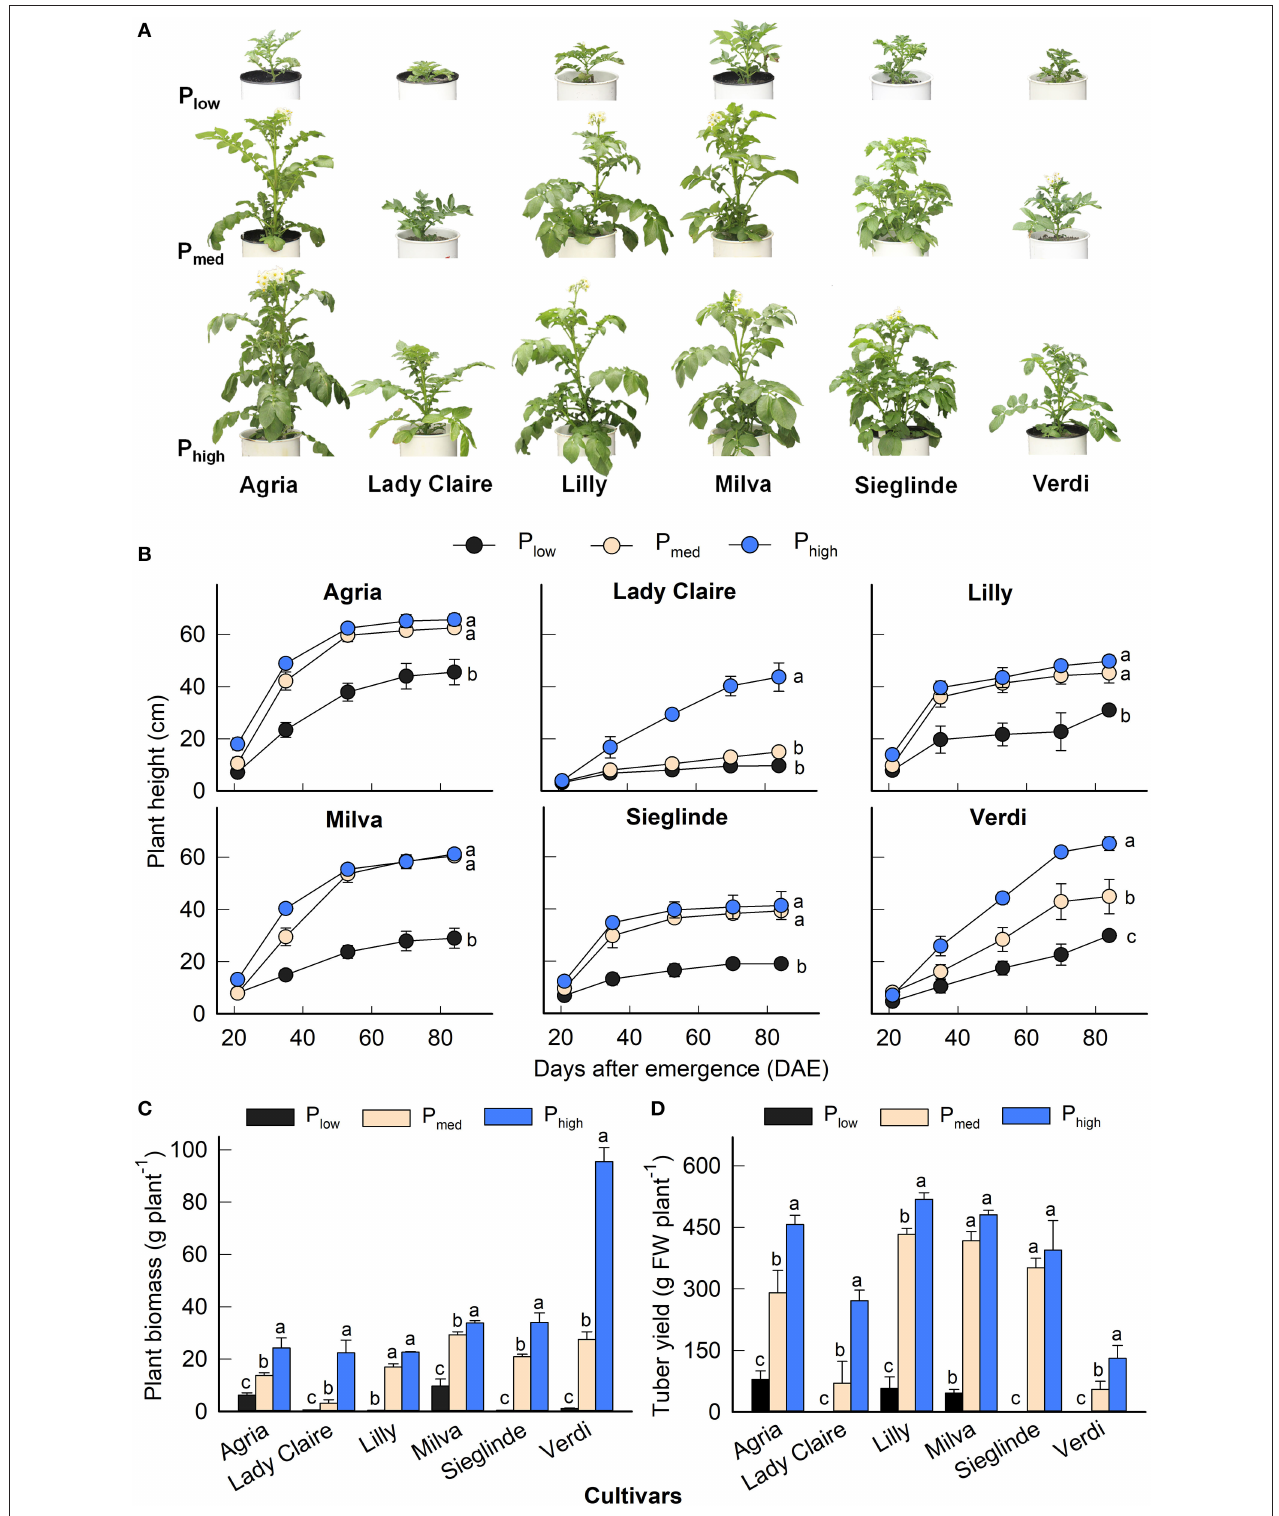
FIGURE 1 | (A) Shoot phenotype 40 days after emergence (DAE), (B) plant height development, (C) plant biomass, and (D) tuber yield of potato cultivars with the application of P low , P med , and P high . Letters in lowercase indicate a significant difference between P treatments of each cultivar by Tukey’s honestly significant difference (HSD) test at p < 0.05. Error bar represents SE of means ( n = 4). FW, fresh weight.